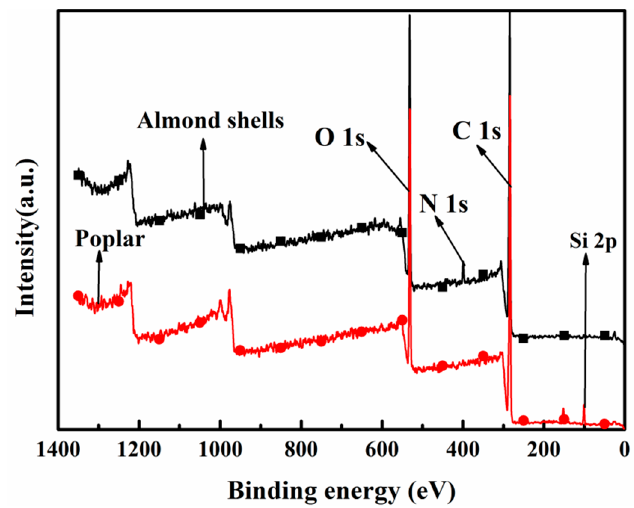
Figure 4. X-ray photoelectron spectroscopy.